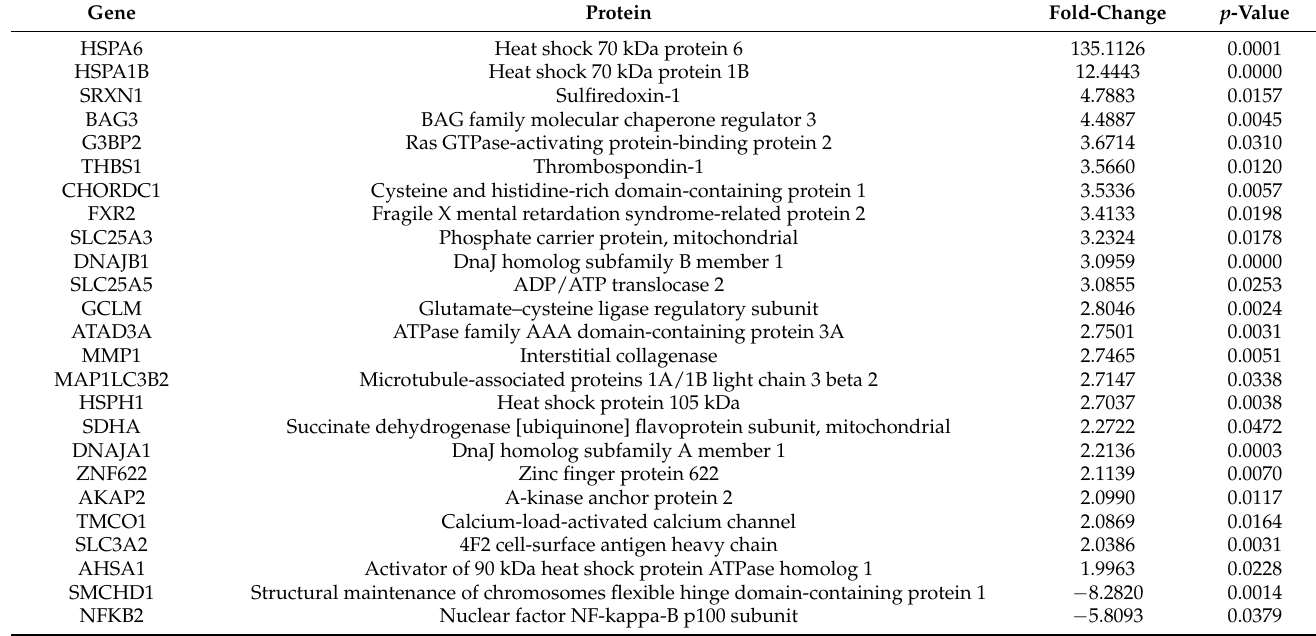
Table 2. Differentially expressed proteins in CuHL2-treated MDA-MB-231